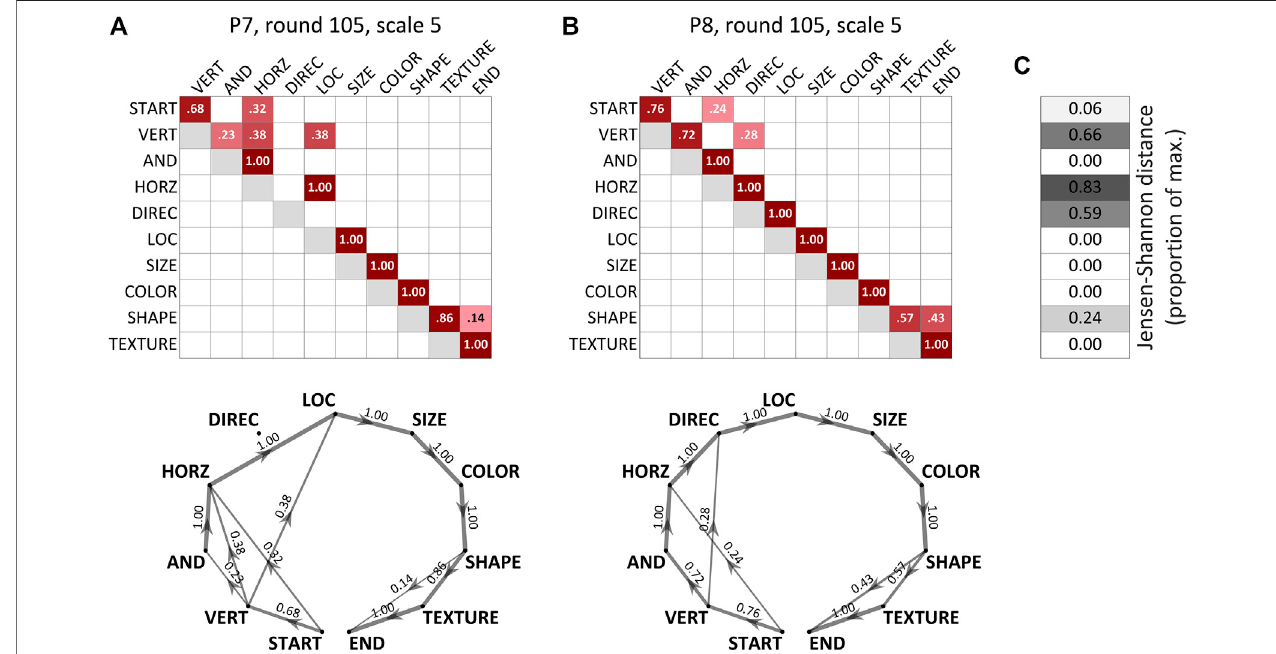
FIGURE7| Examplesoftransitionprobabilitymatricesand Jensen-Shannondistance. (A,B) Transitionprobabilitymatricesanddirectedgraphrepresentationsof Markov chains, calculated over fi ve round windows beginning at round 105. (C) Jensen-Shannon distance (proportion of theoretical maximum) for each row.